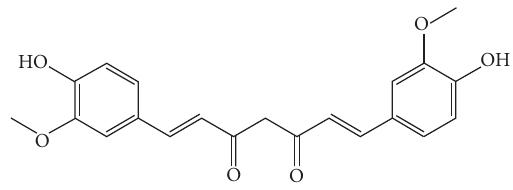
Figure 1: Chemical structure of